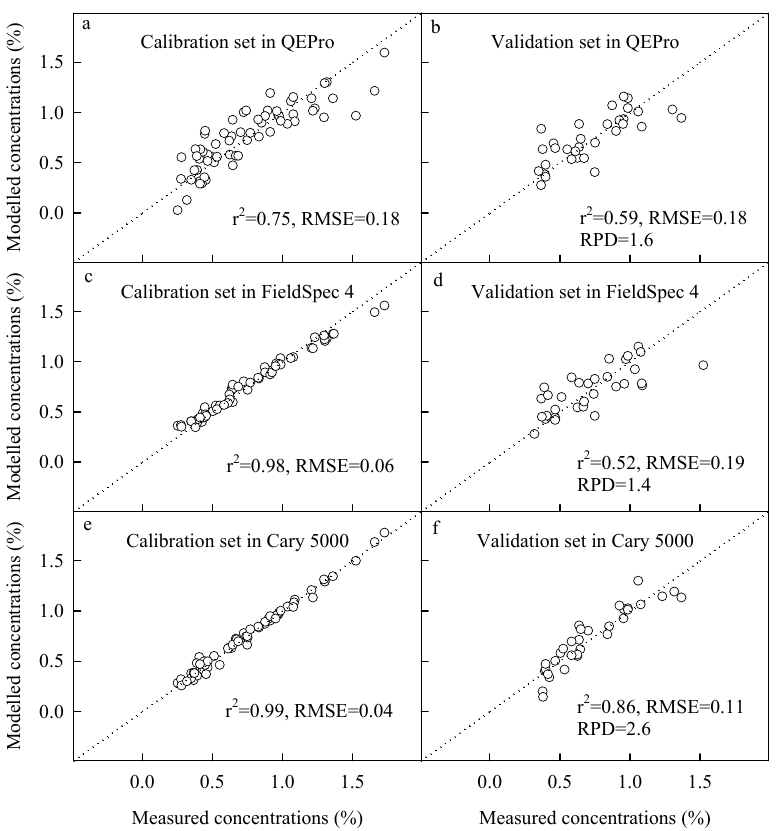
Figure 5. Results of spectral analysis on organic carbon concentrations in sediments of the Yellow Sea and Bohai Sea, China (spectral models for both the calibration set and validation set in QEPro ( a , b ), FieldSpec 4 ( c , d ), and Cary 5000 ( e , f ), respectively).